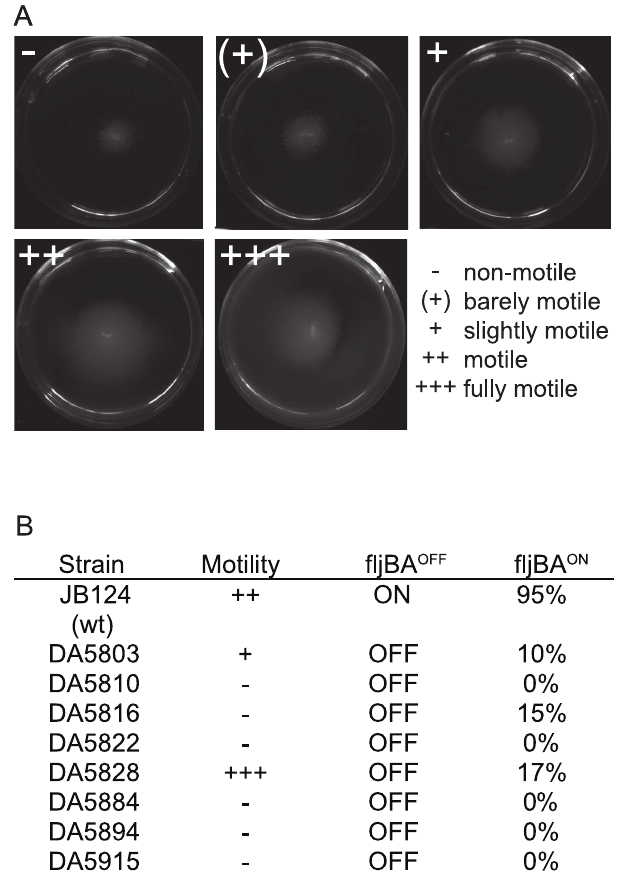
Figure 4. Motility testing on motility agar. A) Illustrating how motility is scored on motility agar. Motility is scored on a 5 step scale where ( 2 ) is non-motile and +++ is fully motile. B) Motility and phase variation of wild type and evolved Salmonella typhimurium strains. FljBA ON cells expressing fljB type of flagellum and FljBA OFF cells expressing fliC type of flagellum. Percentage indicates the fraction of cells (based on whole-genome sequencing) in mouse-adapted popu- lation that were in FljBA ON state.